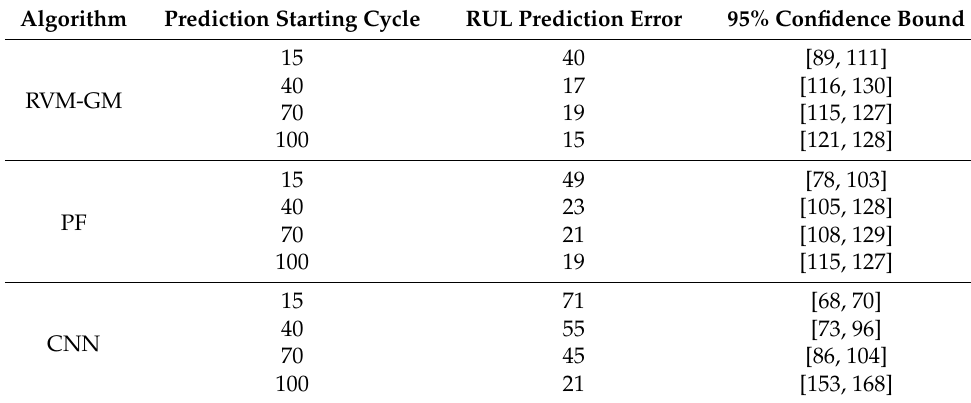
Figure 7. RUL prediction results between RVM-GM, PF and CNN algorithm. Table 3. RUL prediction results for